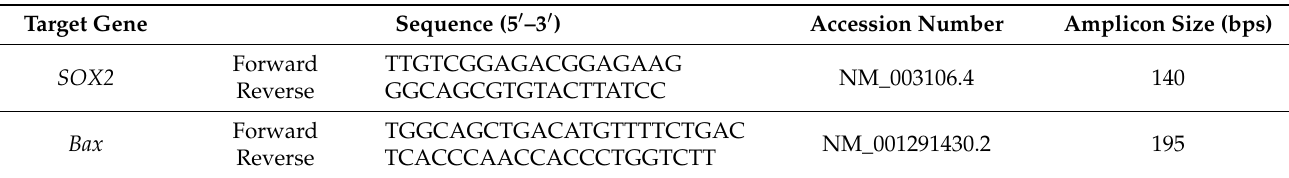
Table 1. Sequence of the oligonucleotide primers used in